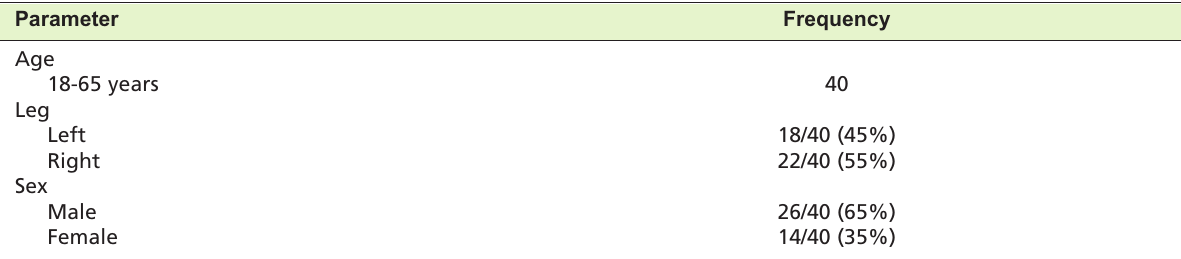
Subject demographics and location of fractures Table I: